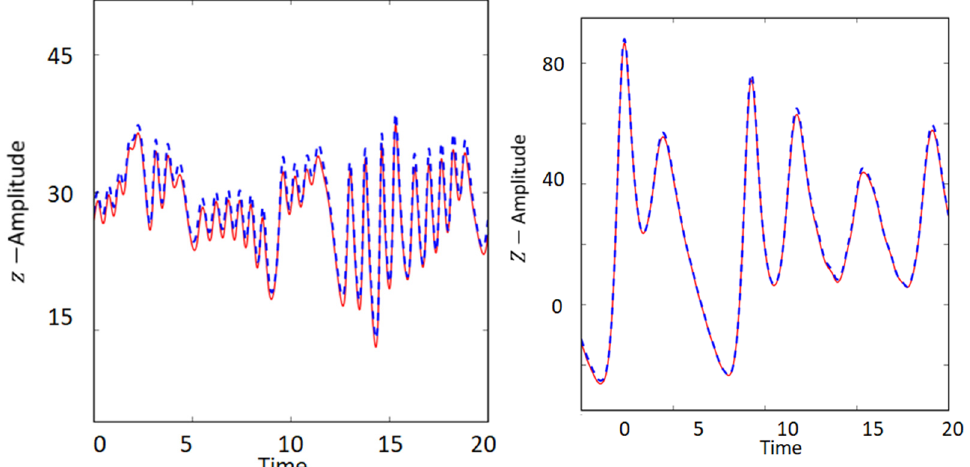
Figure 1. Sensitivity functions of the variables z and Z to the parameter r , which were calculated for strong coupling between fast and slow systems ( 𝑐 = 0.8 ).